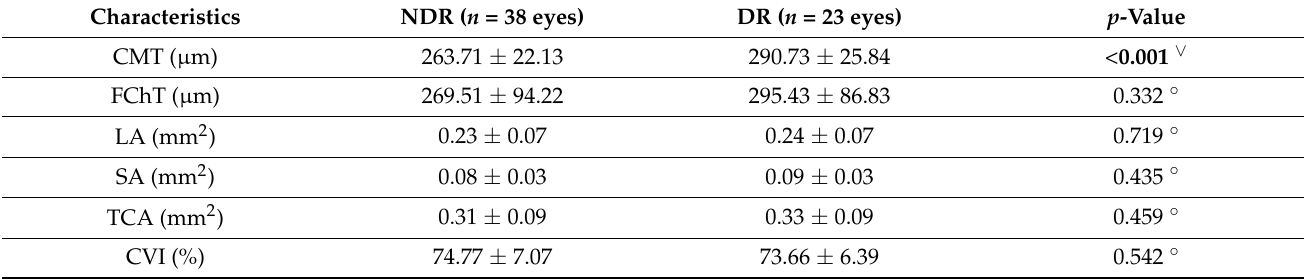
Table 4. Choroidal characteristics and central macular thickness in NDR group versus DR